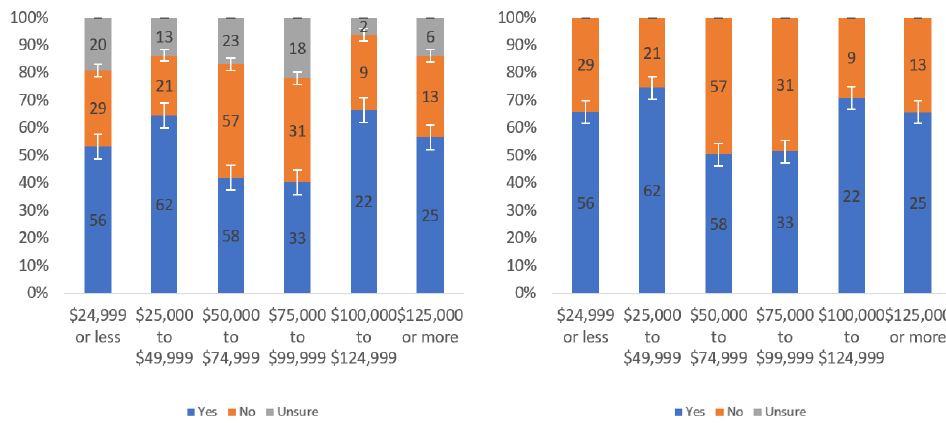
Figure 67. Responses regarding usefulness in judging trustworthiness by income level including ( left ) and excluding ( right ) unsure responses.